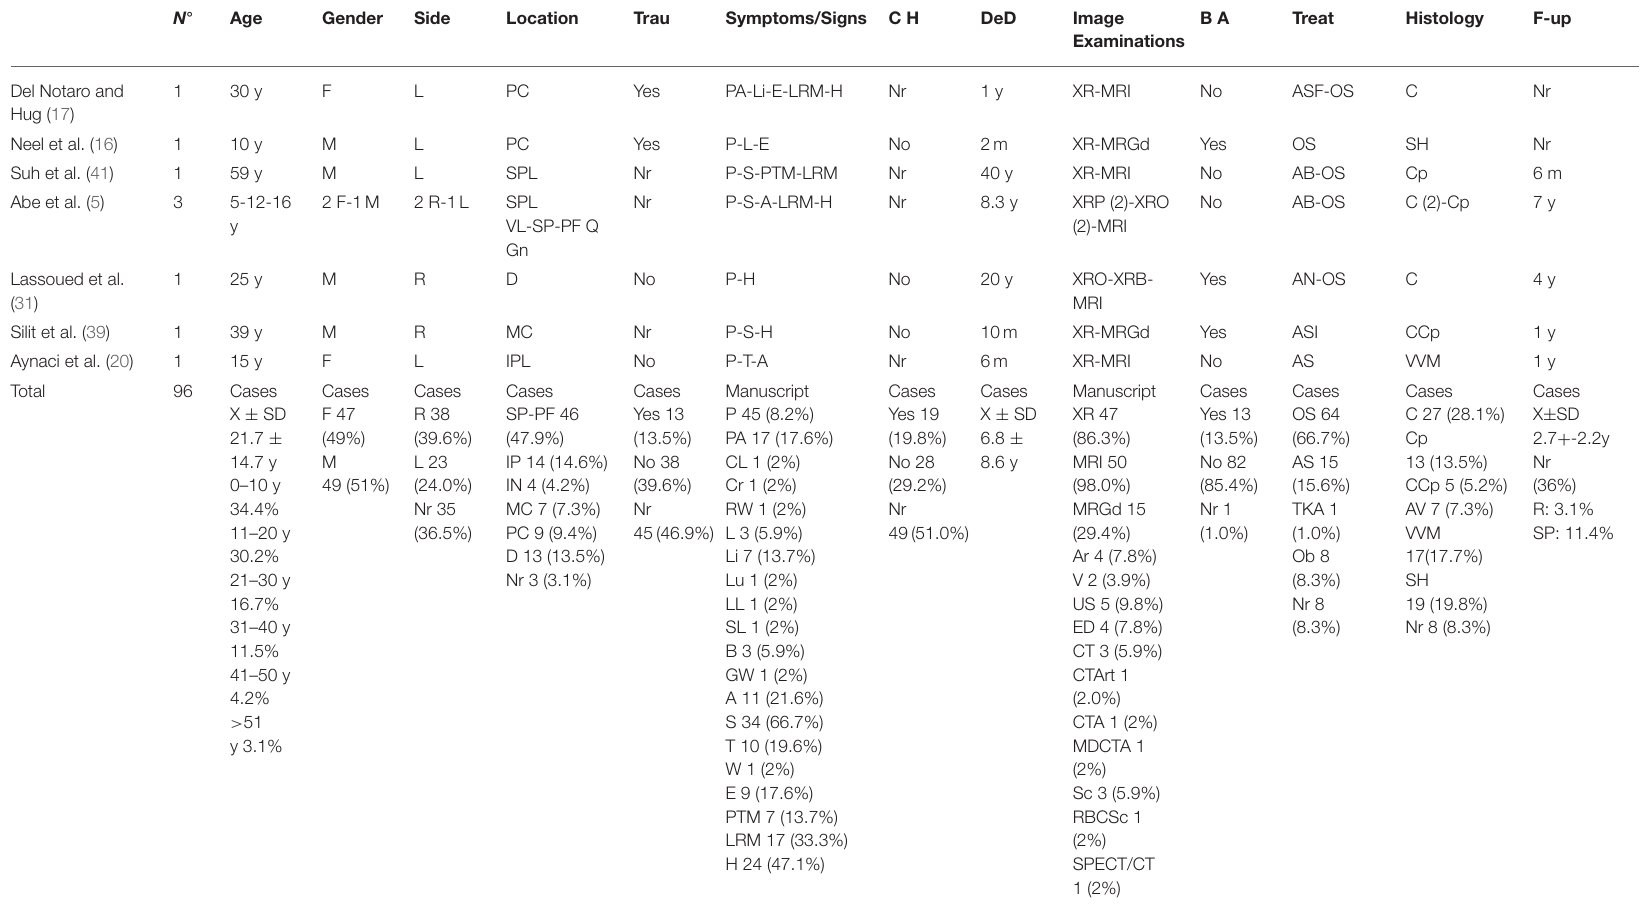
Trau, previous trauma; CH, Cutaneous haemangioma; DeD, Delay in diagnosis; BA, Bone affected; Treat, Type of treatment; F-up, Follow-up; m, Months; y, Years; w, Weeks; R, Recurrence; SP, Symptoms persisted; F, Female; M, Male; R, Right; L, Left; PFL, Patello-femoral lateral; PFM, Patello-femoral medial; IP, Infrapatellar (Hoffa fat pad); IPL, Infrapatellar Lateral; SP, Suprapatellar; SPL, Suprapatellar Lateral; MC, Medial Compartment; IN, Intercondylar Notch; PC, Posterior compartment; D, Diffuse; VMO, Vastus Medialis Obliquus; VL, Vastus Lateralis; Q, Quadriceps; Gn, Gastrocnemius; P, Pain; PA, Pain with Activity; Cl Claudication; Cr, Crepitus; RW, Patient Refused Weightbearing; L, Locking; Li, Limping; Lu, Lump; LL, Long Leg; SL, Short Leg; B, Buckling; GW, Giving Way; S, Swollen; T, Tenderness; W, Warmth; E, Effusion; A, Atrophy; PTM, Palpable tumor mass; PTMF, Palpable Tumor Mass more pronounced in Flexion; LRM, Limited Range of motion; H, Haemarthrosis; SA, Systemic Angiomatosis; KT, Klippel-Trénaunay; XR, radiography; XRS, XR Soft Tissue Mass; XRO, XR Osteoarthritis; XRB, XR Bone Involvement; XRP, XR Phleboliths; Ar, Arteriography; V, Venography; US, Ultrasound; ED, Echo Doppler; CT, Computed Tomography; CTArt, CT Arthrography; CTA, CT Angiography; MDCTA, Multi Detector Computed Tomography Angiography; Sc, Scintigraphy; RBCSc, Red blood cell scintigraphy; SPECT/CT, single-positron emission computed tomography-computed tomography; MRI, Magnetic resonance image; MRIN; MRI negative; MRA, MRI angiography; MRGd, MRI gadolinium enhancement; OS, Open surgery; C, Curettage; BG, Bone Graft; AN, Arthroscopy Negative; AB, Arthroscopic biopsy; AS, Arthroscopic Surgery; ASF, AS Failed. ASI, AS Incomplete; TKA, Total Knee Arthroplasty; Cor, Corticosteroid; Bblo, Beta blockers; C, Cavernous; Cp, Capillary; AV, Arteriovenous; CCp, Cavernous and capillary; SH, Synovial haemangioma; VVM, Venous Vascular Malformation; IAVN, Intraarticular Vascular Malformation; Nr, not reported; X ± SD: media ± standard